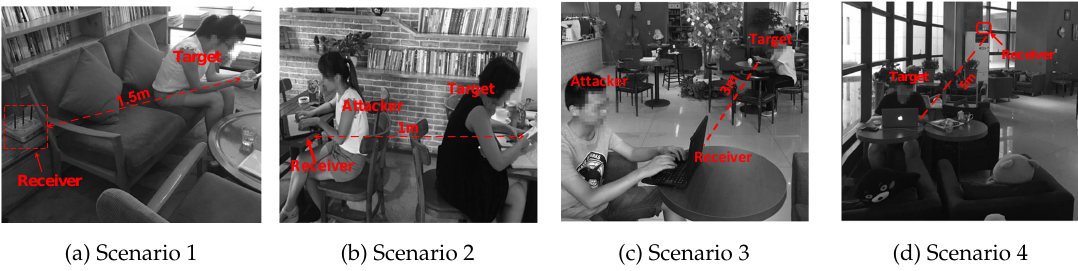
Figure 1. Attack scenarios. The target is inputting sensitive information in a public place, and the attacker uses NIC as the receiver in Scenario 1 and Scenario 4, while in Scenario 2 and Scenario 3, the attacker uses her/his laptop to receive